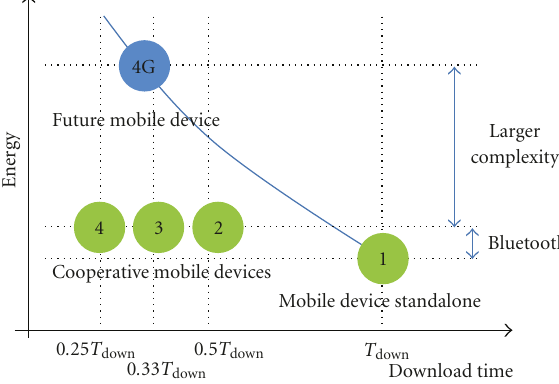
Figure 10: Energy consumption for a state-of-the-art stand alone mobile device, cooperative mobile devices of the same class, and future mobile devices referred to as